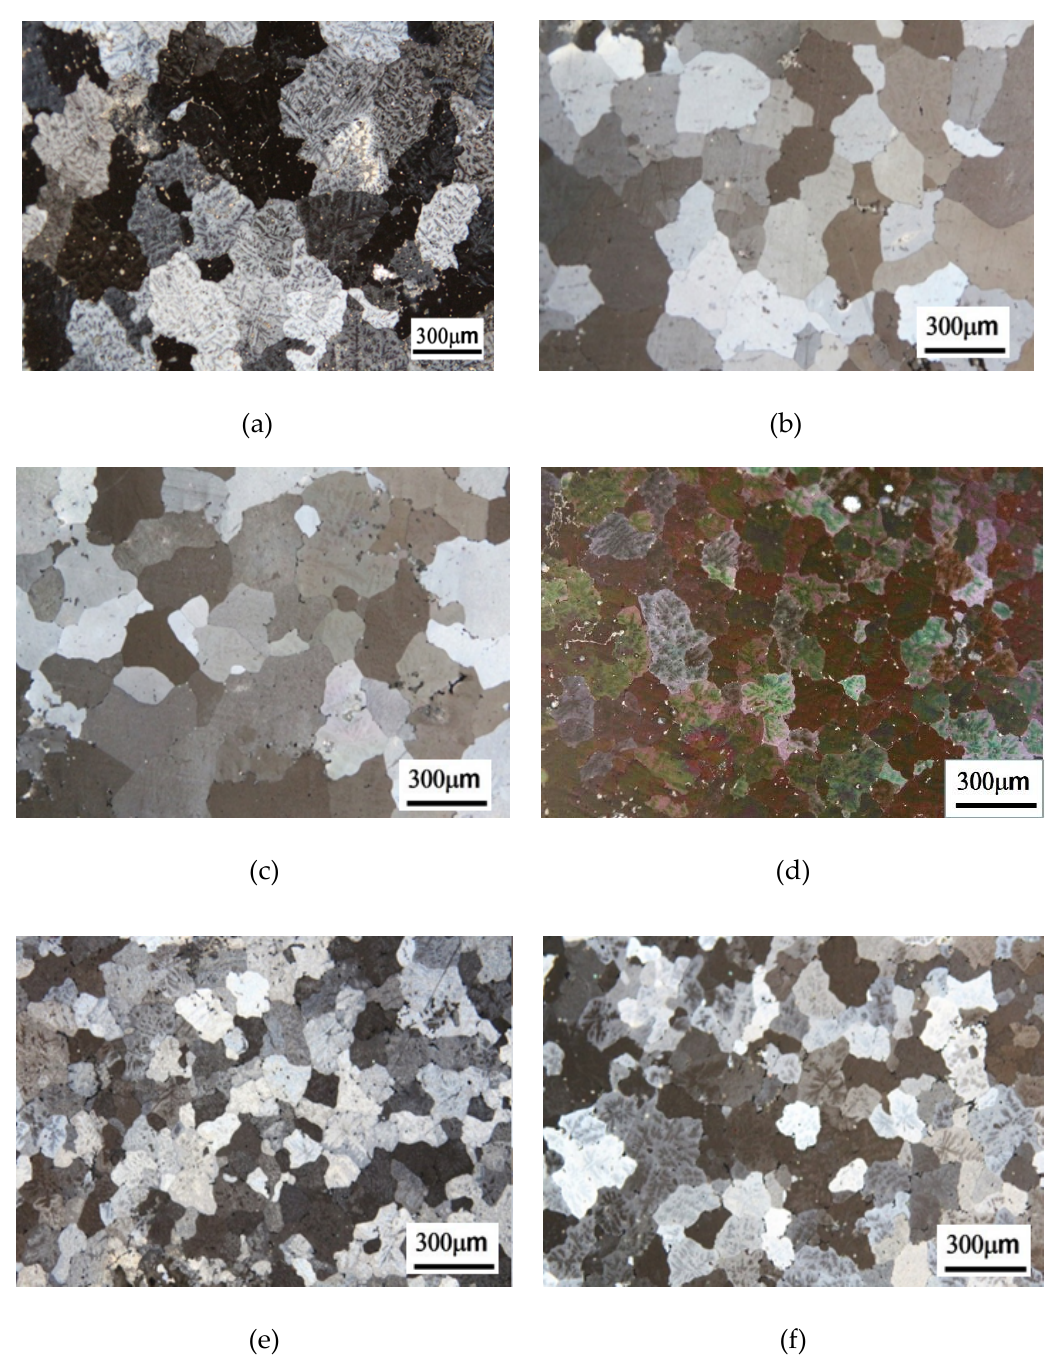
Figure 1. Optical microstructure observations of ( a ) as-cast Alloy A (0Mn); ( b ) 1-Homo Alloy A (0Mn); ( c ) 2-Homo Alloy A (0Mn); ( d ) as-cast Alloy B (0.8Mn); ( e ) 1-Homo Alloy B (0.8Mn); ( f ) 2-Homo Alloy B (0.8Mn). 1-Homo: after the one-stage homogenization; 2-Homo: after the two-stage homogenization.